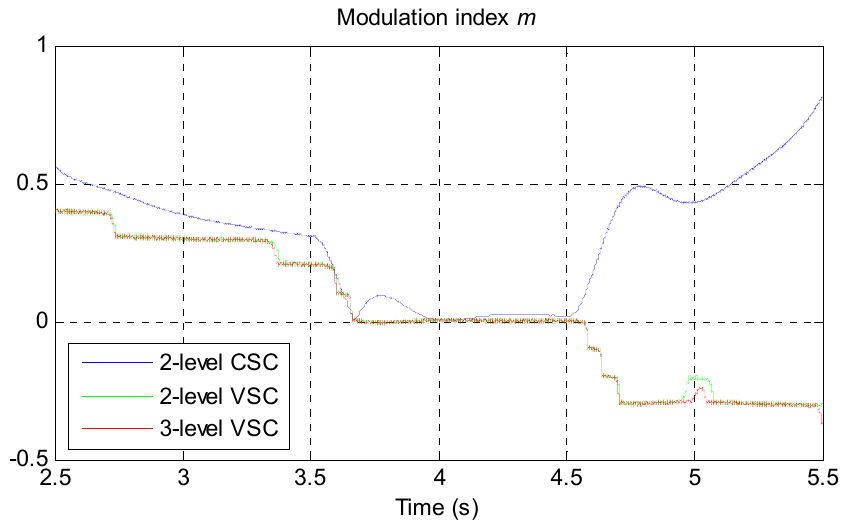
Figure 21. Comparison of the modulation indices in each system.